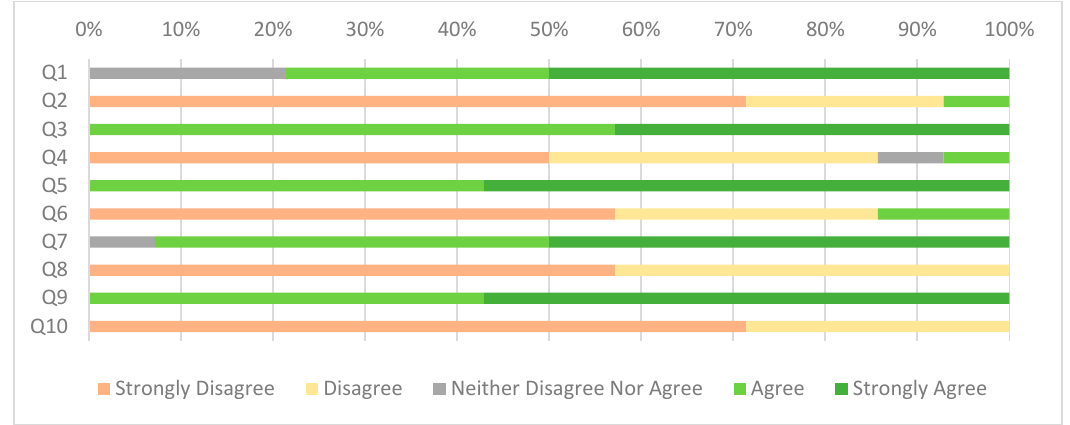
Figure 3. Current measurements with INA219 (battery was at ~3.64 V) as described in Section 2.4.1. ( A ) Medication schedule update, ( B ) sound notifications at the pill intake time, ( C ) LED notifications indicating the appropriate pills for intake, and ( D ) acquisition of food or supplement photo and upload to the server for interaction check.